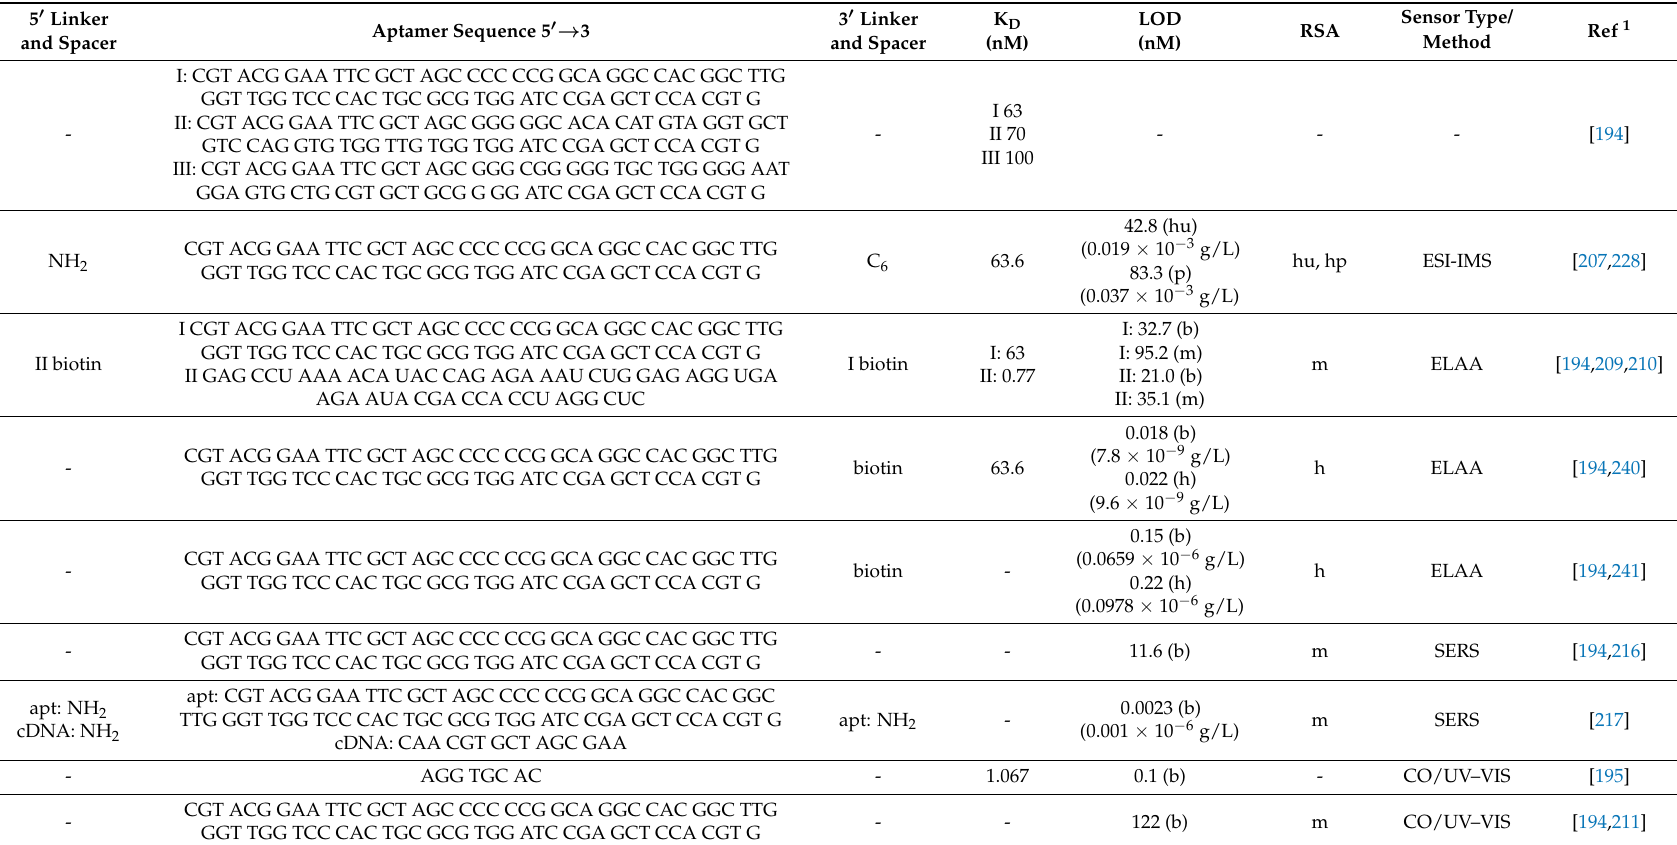
Table 16. Aptamer sequence, dissociation constant (K D ), limit of detection (LOD), real sample analysis (RSA), and realized sensor type and measuring method for tetracycline, mentioned in the corresponding references (Ref). AEC = amperometric electrochemical, apt = aptamer, b = buffer, cap = capture probe, cDNA = complementary DNA, CO = colorimetric, DPV = differential pulse voltammetry, EIS = electrochemical impedance spectrometry, ELAA = enzyme-linked aptamer assay, ESI-MS = electrospray ionization-ion mobility spectrometry, FAM = fluorescein amidite, FIS = Faradaic impedance spectroscopy, FL = fluorometric, h = honey, hp = human plasma, hs = human serum, hu = human urine, IEC = impedimetric electrochemical, m = milk, p = pork, PEC = photoelectrochemical, rs = rat